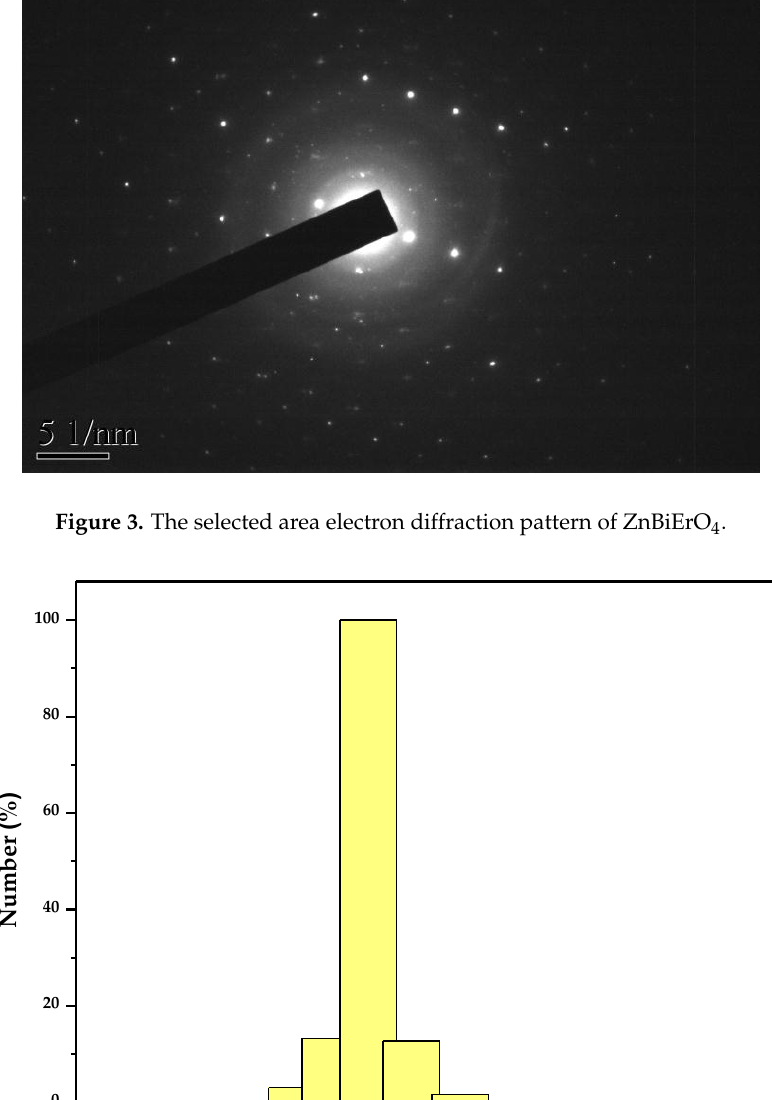
Figure 4. The diagram of particle size of ZnBiErO 4 .